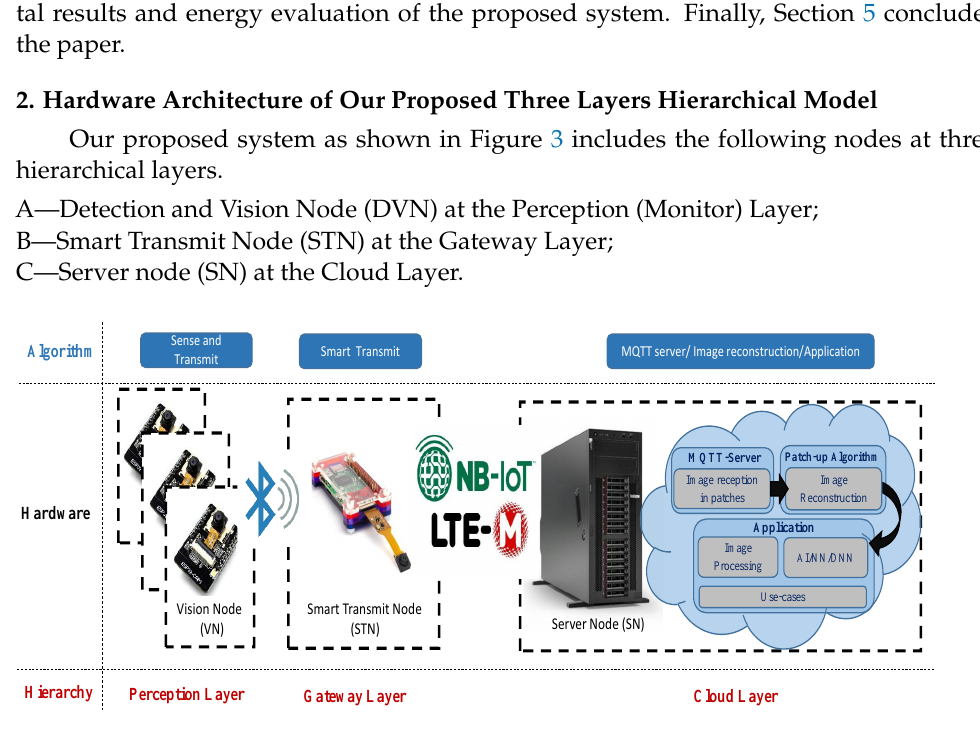
Figure 3. Proposed three-layer hierarchical model for energy-efficient image transfer via